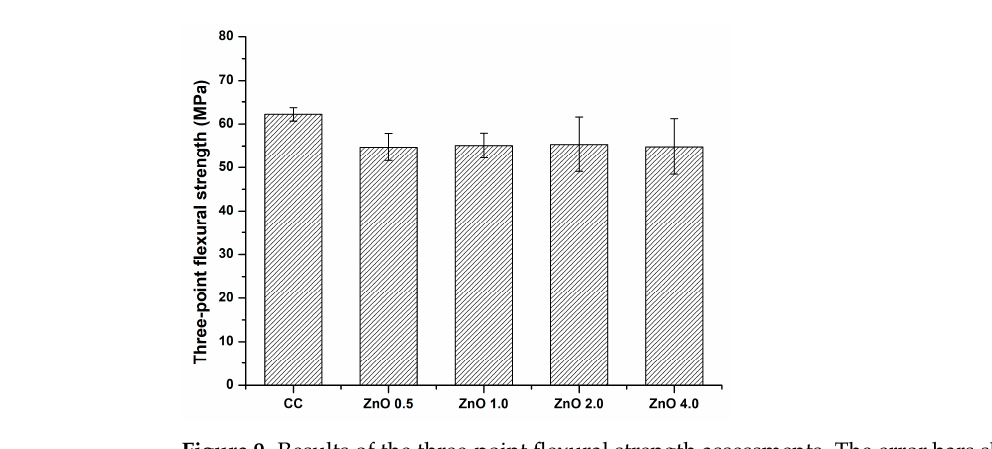
Figure 9. Results of the three-point flexural strength assessments. The error bars show the standard deviation of the mean values. The groups showed no significant differences ( p > 0.05).